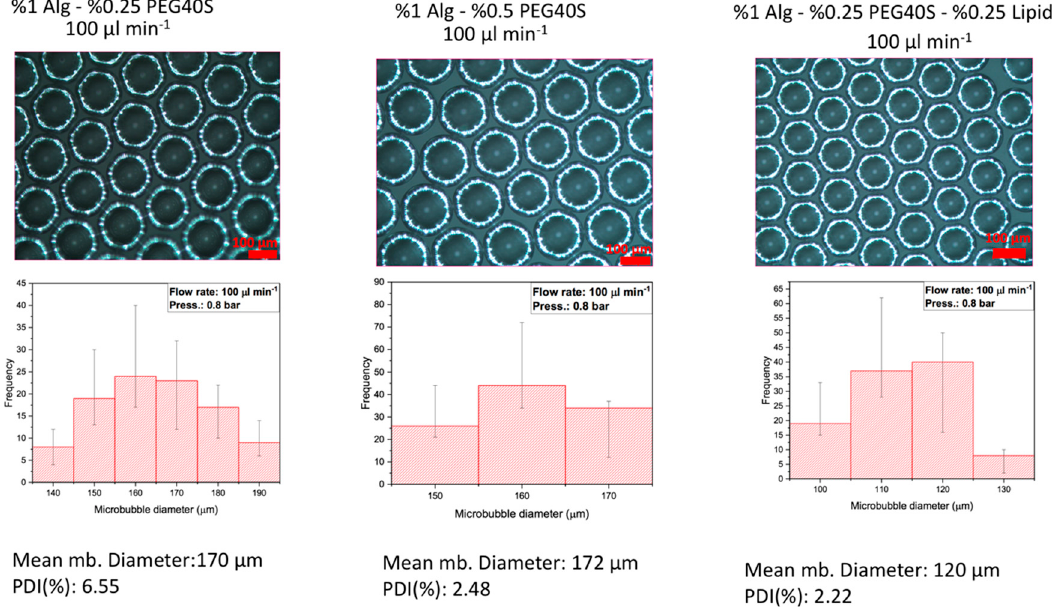
Figure 3. Effects of PEG-40S (surfactant) and phospholipid concentrations on the diameter and size distribution of the microbubbles obtained at a constant N 2 gas pressure of 0.8 bar and feeding liquid’s flow rate of 100 µ L · min − 1 (phospholipid is denoted by Lipid). Data are presented as mean ± SD, n ≥ 100 microbubbles.